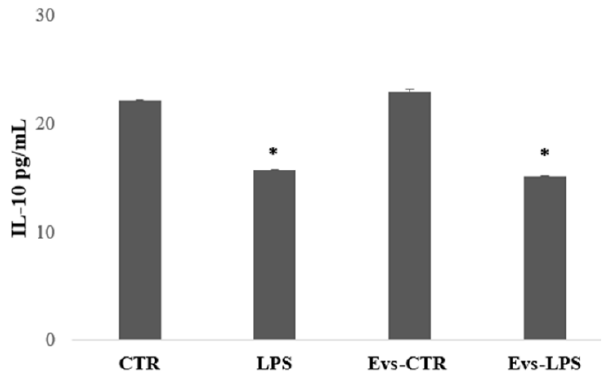
Figure 6. The amount of IL-10 production in supernatant was evaluated by ELISA. IL-10 was increased in BV-2 cells in the control and stimulated with EVs CTR. (* p -value < 0.05 compared to control cells). Data are expressed as the mean ± SD of three independent experiments.